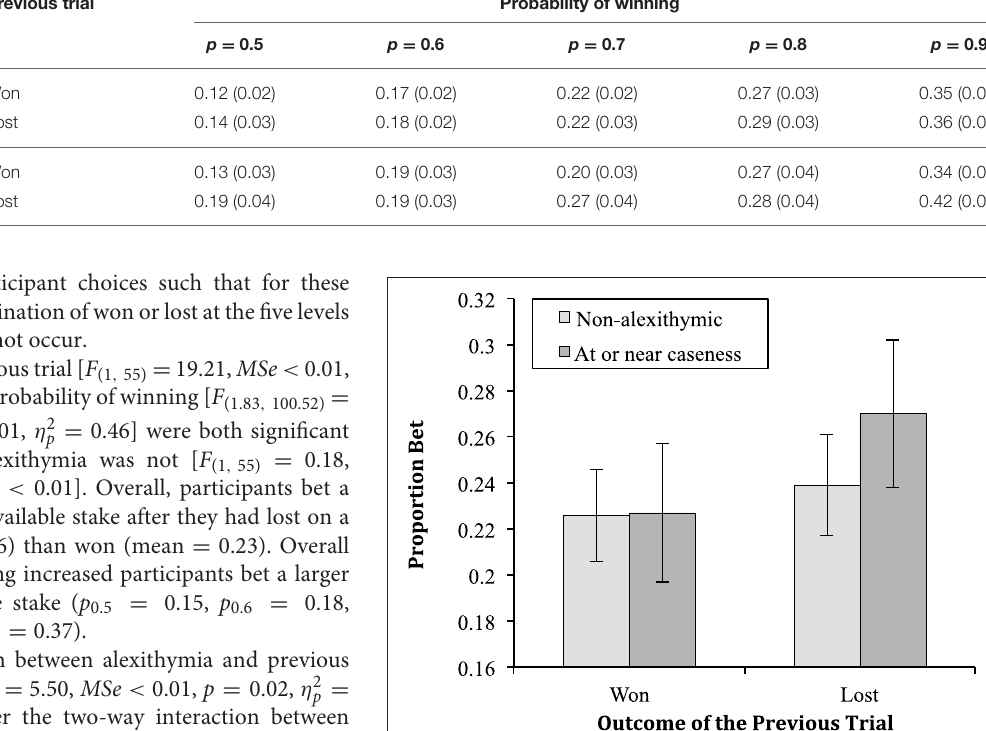
TABLE 3 | Means (and standard errors) of the proportion bet for the alexithymia groups by outcome of the previous trial and probability of winning on the current trial. Alexithymia Previous trial Probability of winning